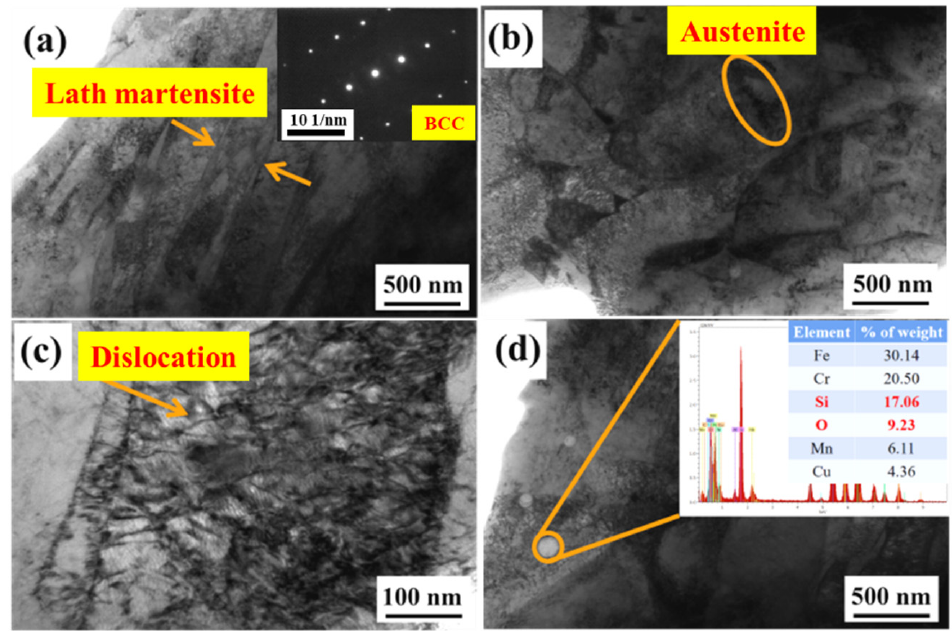
Figure 2. TEM images of the morphology of the 17-4PH high-strength steel formed by SLM: ( a ) martensite; ( b ) austenite; ( c ) dislocation; ( d ) precipitates. Barroux et al. [19] mention that the formation of these inclusions in the forming process is considered a manufacturing defect, despite the use of protective gas. Si-rich